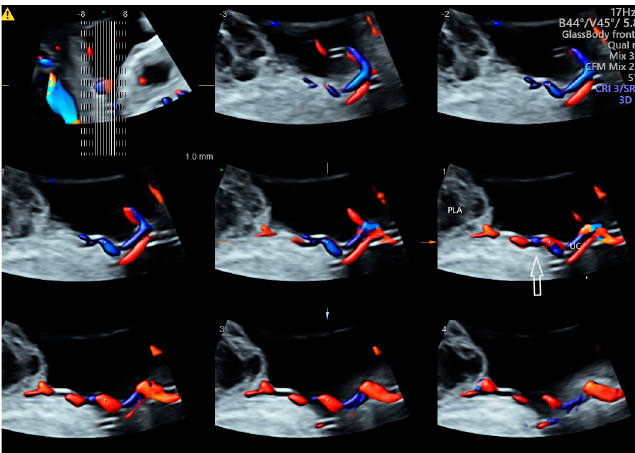
Figure 6. Two-dimensional color-flow imaging ( A ) and glass-body rendering mode with color-flow Doppler ( B ) showing a placental surface cyst (PSC) associated with marginal insertion (arrow) of the umbilical cord (UC) into the placenta (PL) at 17 weeks’ gestation. For comparison, a central cord insertion (arrow) is noted in another fetus ( C ) at 21 weeks’ gestation.